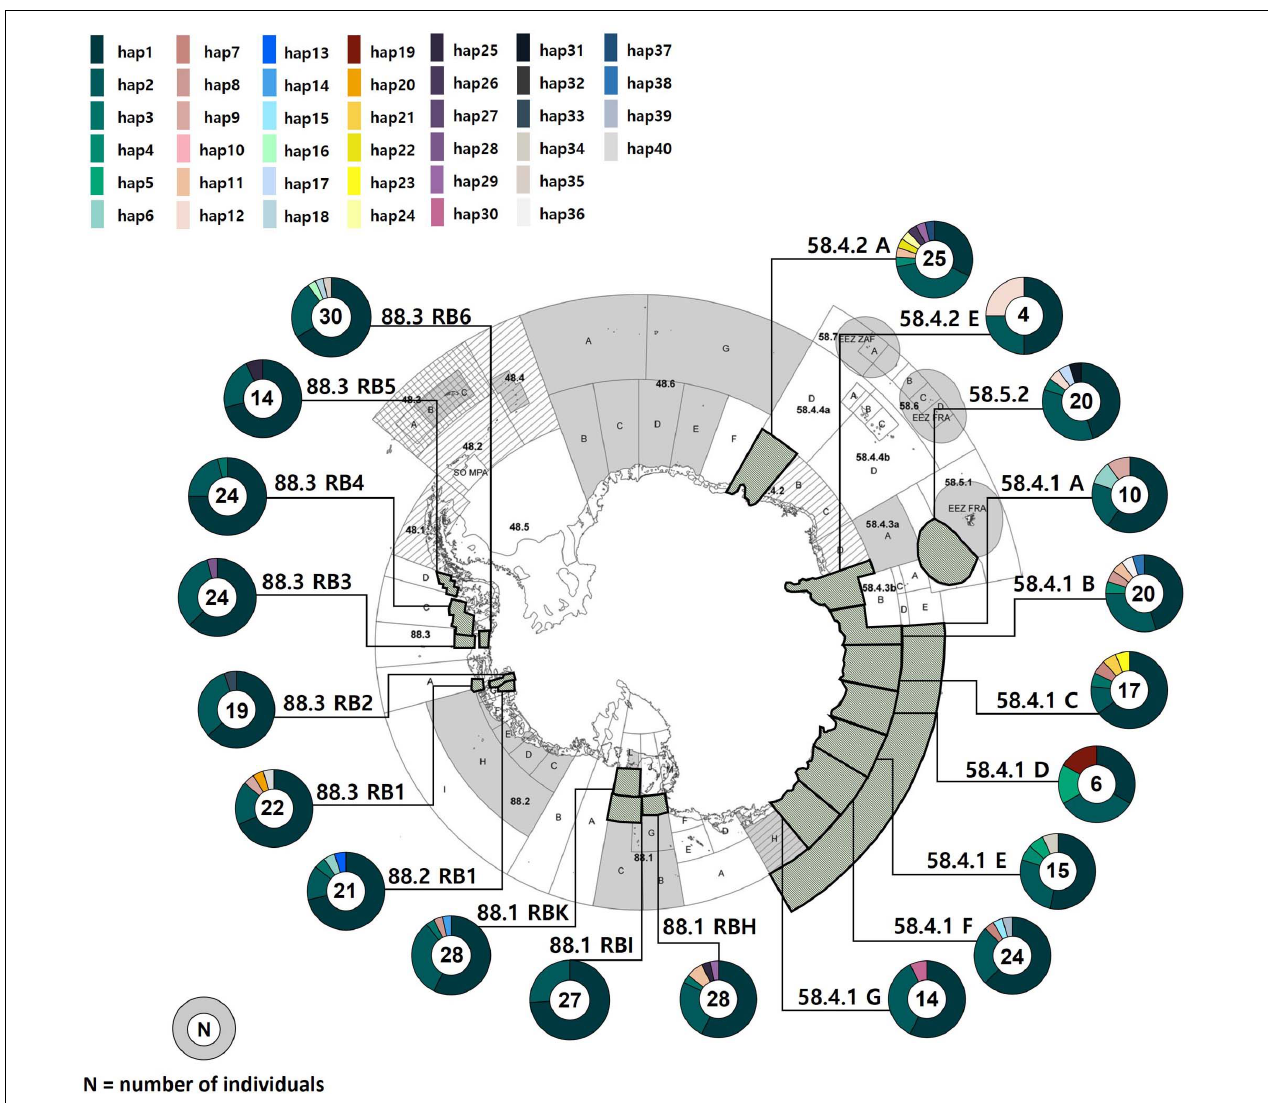
FIGURE 1 | Sampling localities of Dissostichus mawsoni and the geographic distribution of mitochondrial DNA COI and 16S haplotypes (1,304 bp) that we determined. Each polygon in the map represents sampling areas. Different colors in circles denote 40 different haplotypes that show relative frequencies within populations. The map was extracted from CCAMLR area (Everson,